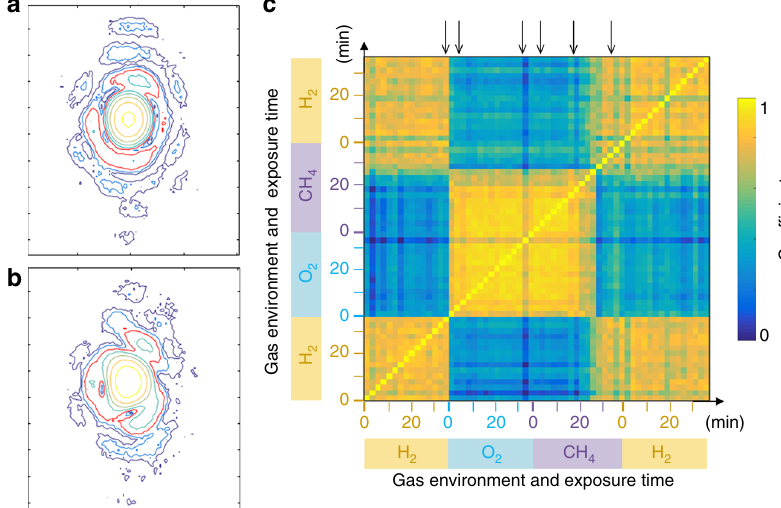
Fig. 2 The cross-correlation map of the coherent X-ray diffraction (CXD) patterns. a , b Contour of intensities for the CXD pattern shown in Fig. 1a and Fig. 1b, respectively, with the red contour identifying the fi rst fringes. c The cross-correlation map between each CXD pattern above activation temperature as a function of different gas fl ow conditions. The areas used in the correlation analysis are indicated as dashed boxes in the Supplementary Fig. 3a, b. Gas environments together with the exposure times are indicated on the x and y axis. Black arrows on the top show the time and gas environment for Fig. 1a – f. Time 0 indicates the start of each gas fl ow (1% H 2 , 20% O 2 , 1% CH 4 , and 1% H 2 ). The correlation coef fi cient, 1, means total positive linear correlation and 0 no linear